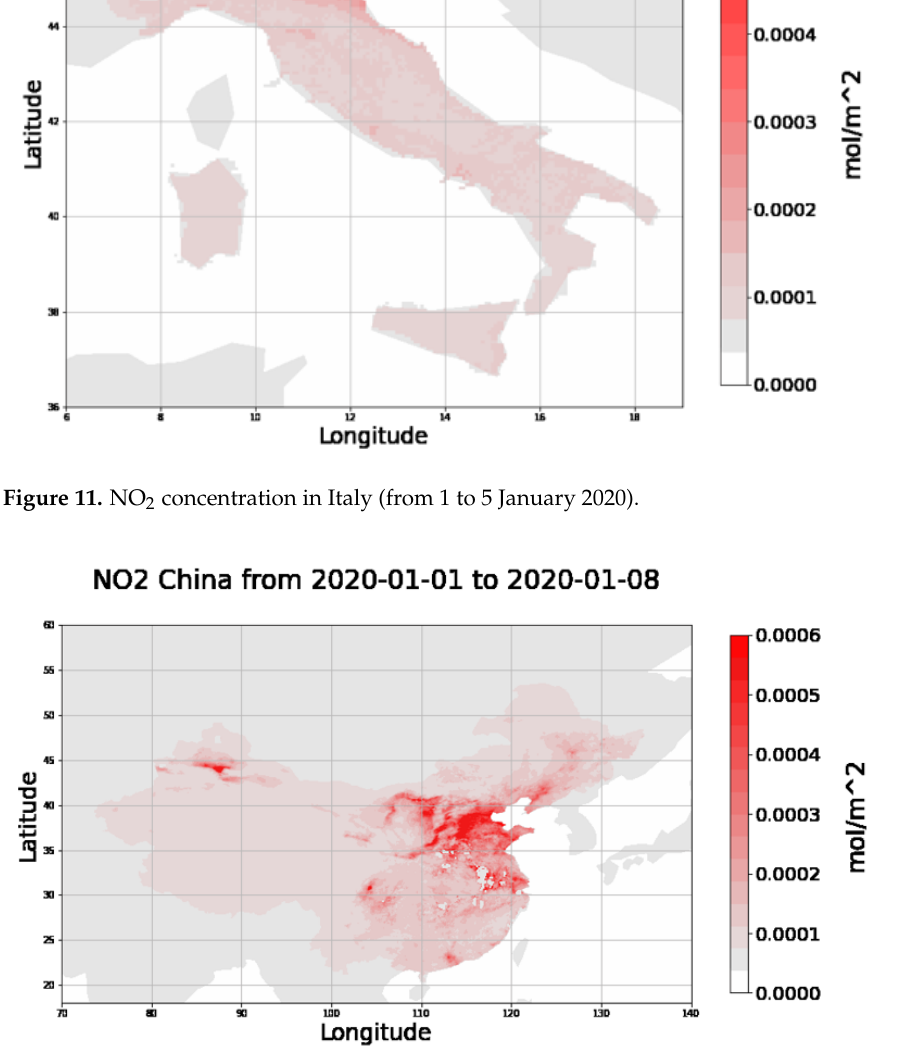
Figure 12. NO 2 concentration in Hubei, China (from 1 to 8 January